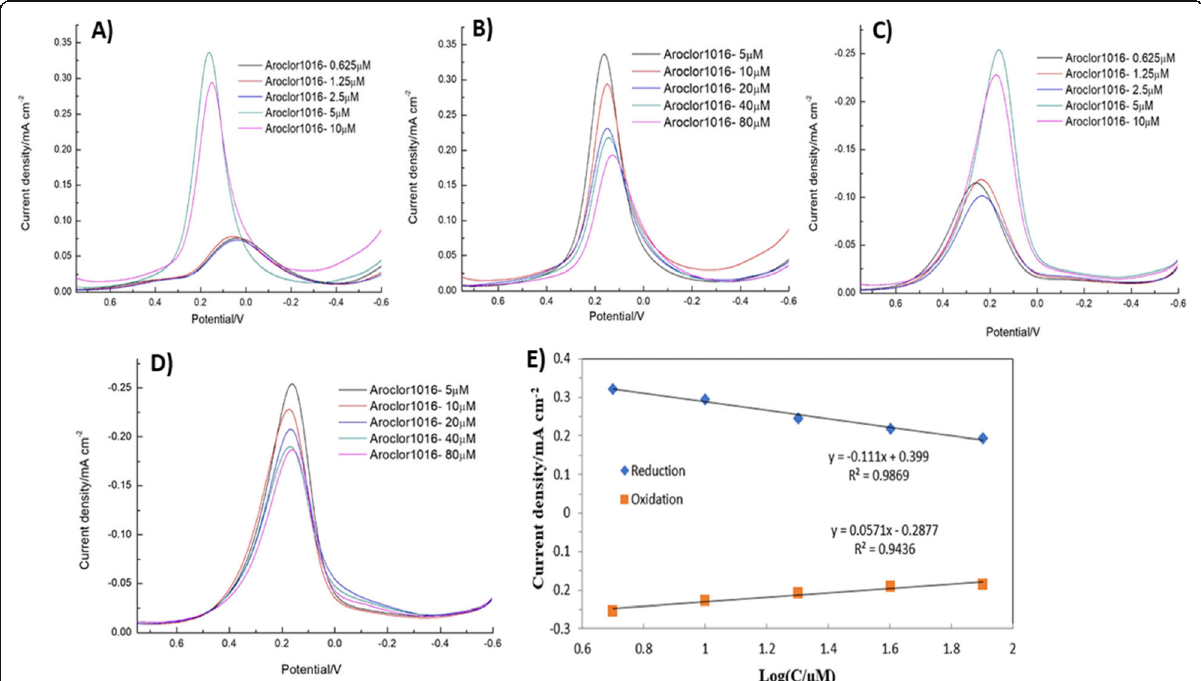
Fig. 8 a , b DPV response of the reduction peak current depends on the different concentration addition of PCBs (Aroclor 1016). The different concentration addition of PCBs (Aroclor1016) at 0.625 – 10 μ M into the electrolyte solution ( a ). The higher concentration addition of PCBs (Aroclor 1016) (5 – 80 μ M) ( b ). c , d The oxidation peak current depends on the different concentration addition of PCBs (Aroclor 1016). e The plot between the oxidation and reduction peak current density versus log concentration of PCBs (Aroclor